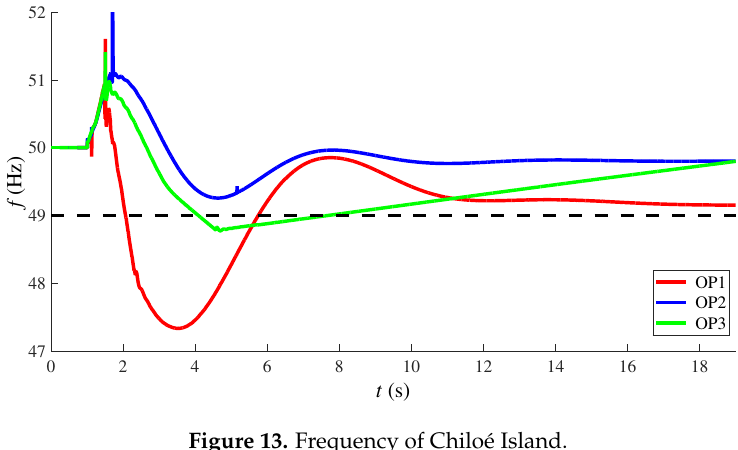
Figure 13. Frequency of Chiloé